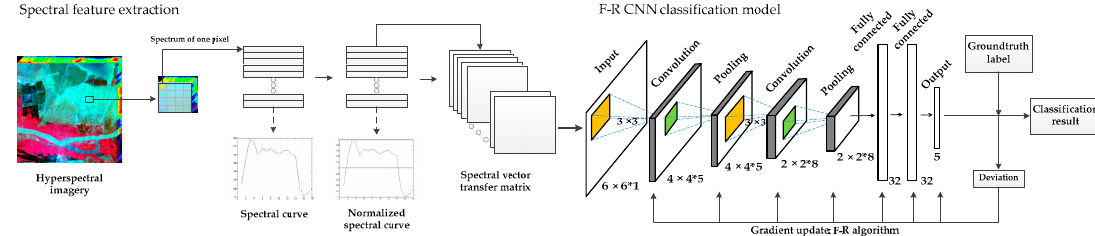
Figure 3. Proposed F–R CNN classification model. The structure includes the extraction process of spectral features and the convolutional neural network (CNN) classification model based on the Fletcher–Reeves (F–R) algorithm. Table 3. The structure and parameters of the proposed F–R CNN.